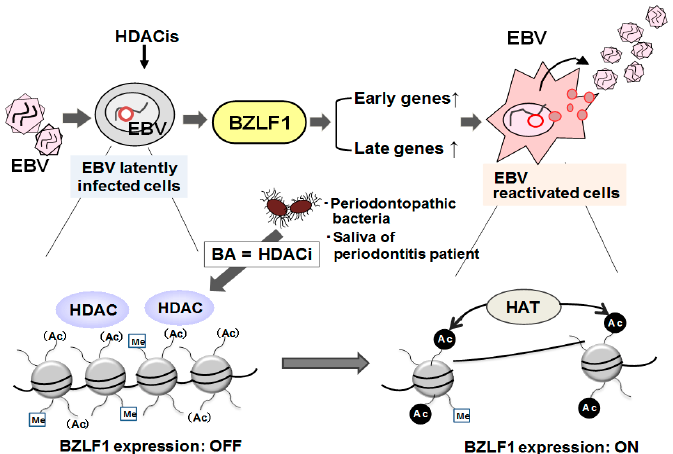
Figure 2. Induction of the EBV lytic switch transactivator BZLF1 involving epigenetic regulation. The latent form of EBV can be induced to enter the lytic replication cycle by treatment with various inducers such as HDAC inhibitors (e.g., BA and trichostatin A), TPA, and antibodies against immunoglobulins. These inducers lead to increased transcription of the immediate–early EBV gene, BZLF1, which encodes ZEBRA. In the latent state, hypoacetylation of histone proteins in the BZLF1 promoter by HDACs is primarily involved in the maintenance of EBV latency. Upon cellular stimulation, local histones are acetylated, the negative regulators are dismissed together with HDAC proteins, and BZLF1 transcription is initiated. BZLF1 can transactivate both early and late EBV genes, thereby inducing the lytic cycle cascade. Replicated EBV infects other cells, thereby further spreading the EBV infection. Periodontopathic bacteria such as P. gingivalis and F. nucleatum produce high concentrations of BA. Thus, periodontopathic bacteria can induce BZLF1 expression by stimulating acetylation of histones and HDAC dissociation from the BZLF1 promoter in latently infected cells, and BA may be responsible for this effect. BA, butyric acid; BZLF1, BamHI Z fragment leftward open reading frame